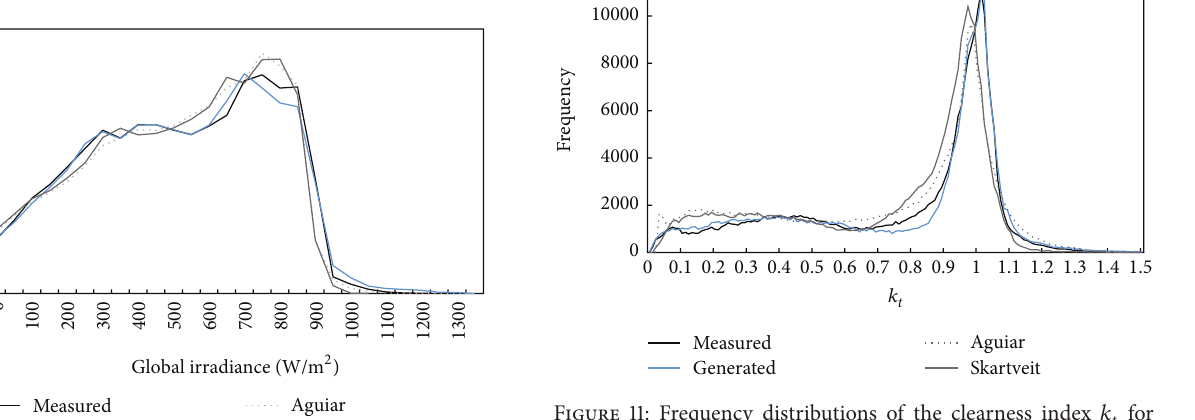
Figure 11: Frequency distributions of the clearness index 𝑘 𝑡 for Carpentras (France, 2001). For locations with higher yearly global irradiation, the second peak (clear sky) of the distribution grows. With the new method, the RMSE between measurement and synthesis can be reduced significantly (RMSE = 801 and 962 counts for Aguiar and Skartveit and RMSE = 248 counts for new